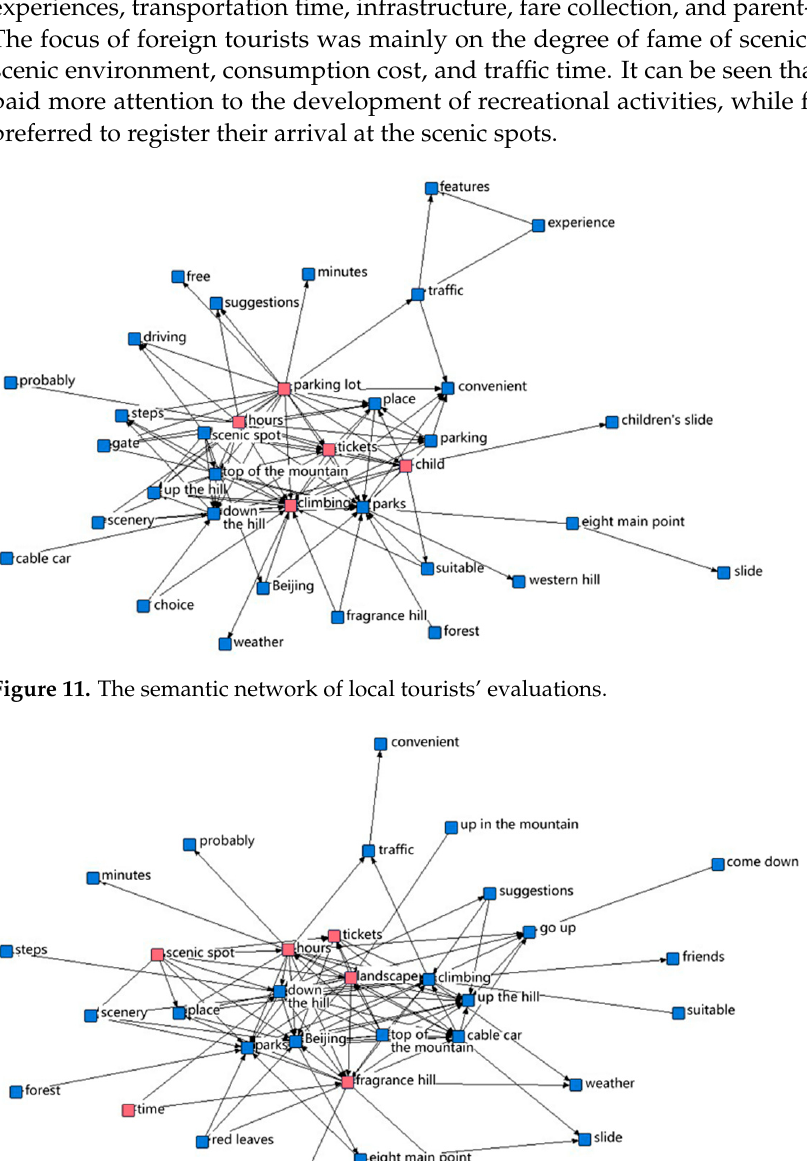
Figure 10. The semantic network of negative evaluations.